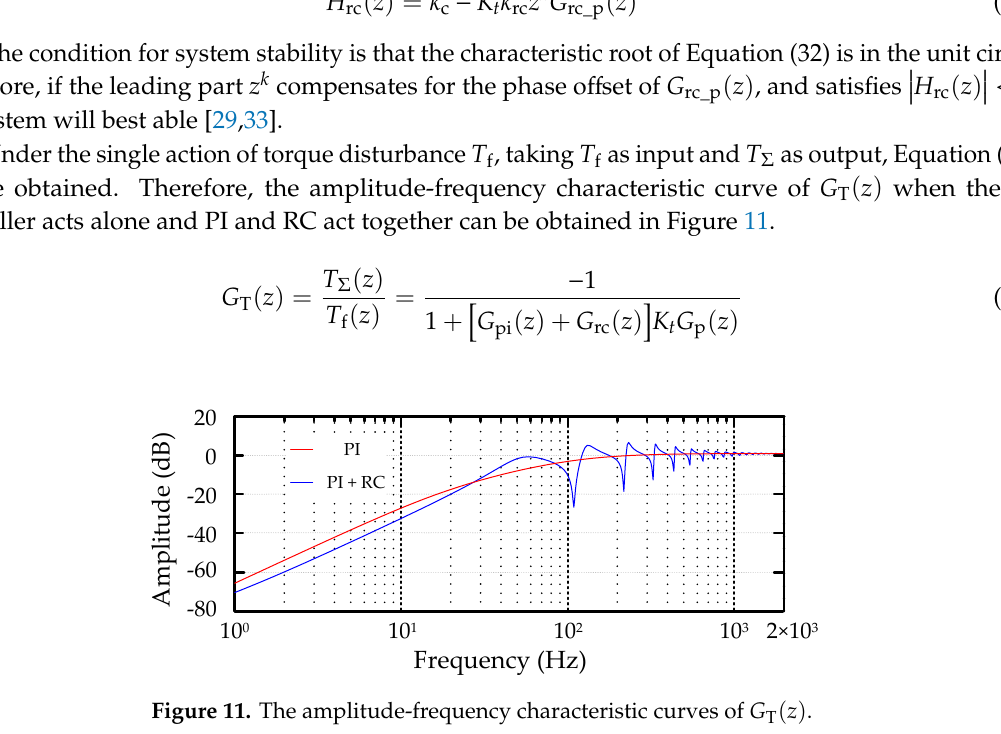
G z . T G z . Figure 11. The amplitude-frequency characteristic curves of G T ( z ) . T